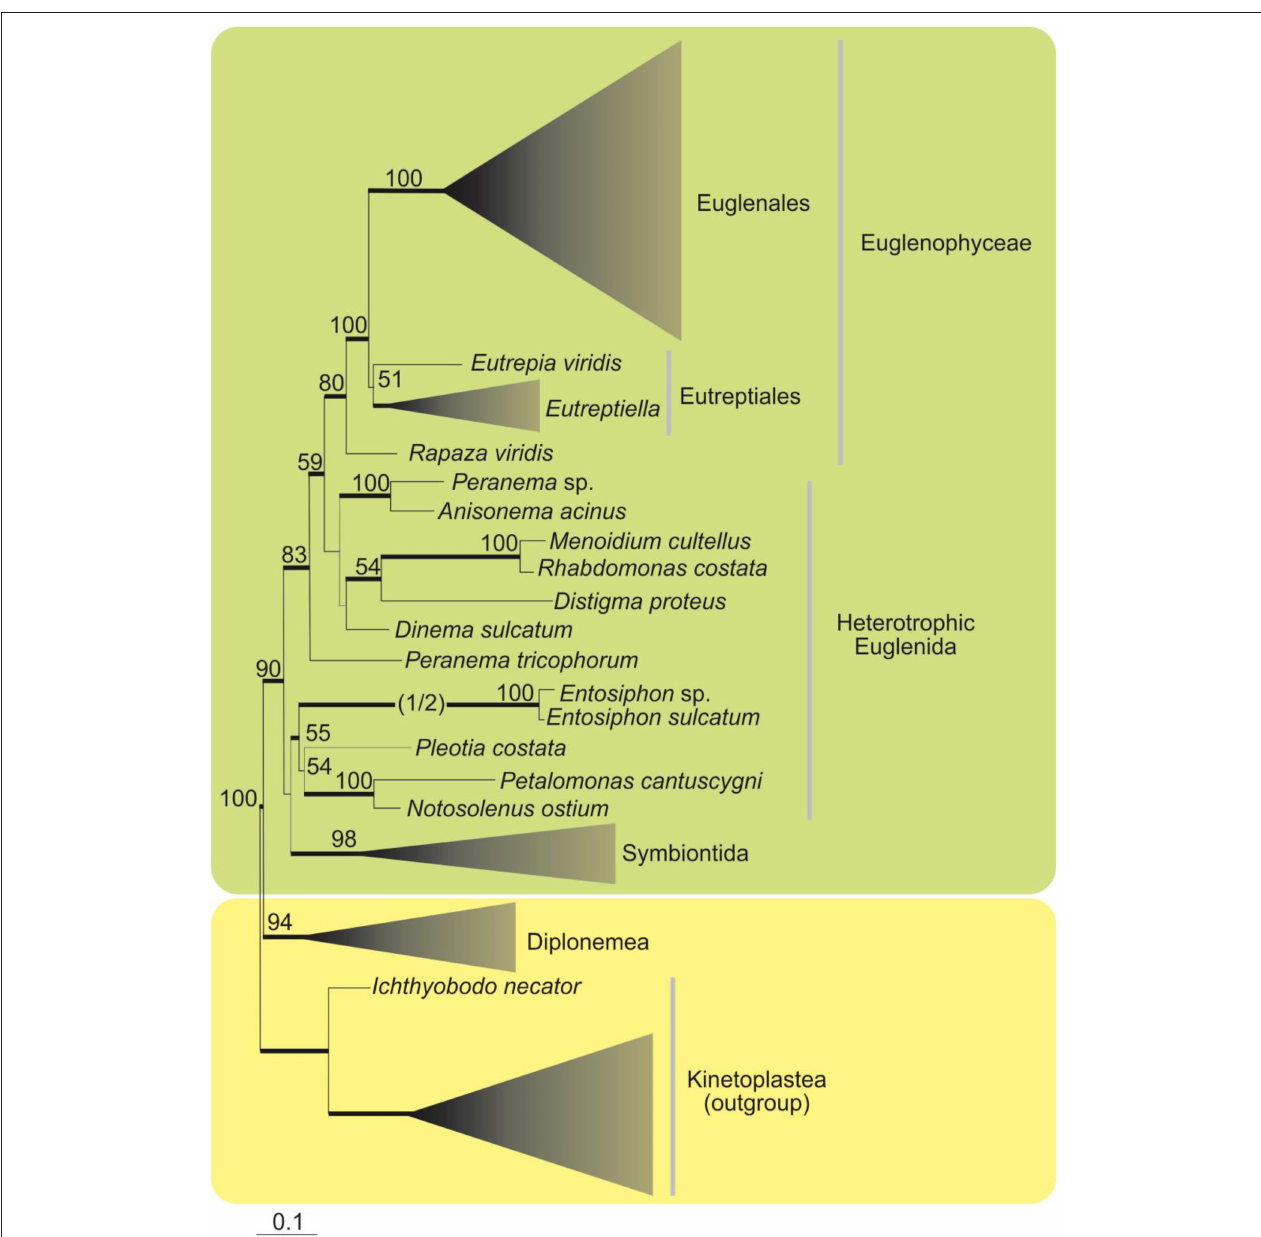
FIGURE 2 | Maximum-likelihood tree inferred from SSU rDNA sequences showing the phylogenetic position of the Euglenophyce within Euglenozoa. Only support values above 50% for the ML bootstrap analysis are shown. Thick branches indicate Bayesian posterior probabilities (PP) over 0.95. The branch leading to the fast-evolving Entosiphon clade has been shortened by one half (indicated by “1/2”; Adapted from Yamaguchi et al., 2012).